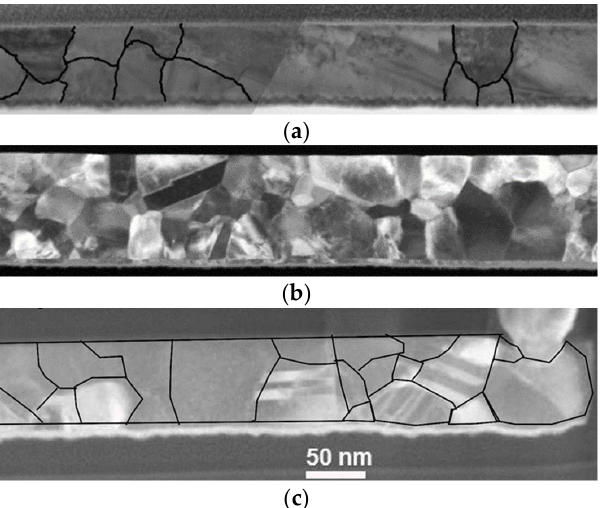
Figure 4. TEM images along Cu ( a ) 80 nm ( b ) 50 nm, and ( c ) 28 nm wide lines. Black lines represent grain boundary locations. Reprinted with permission from ref. [60]. Copyright 2013, Springer Na-